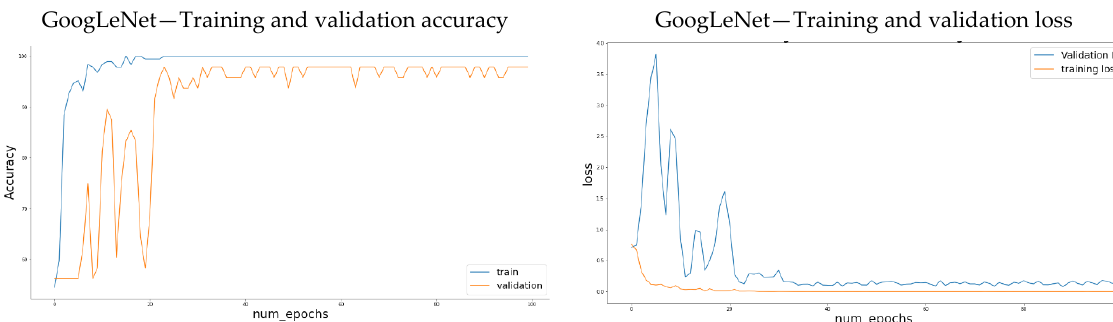
Figure 8. Training and validation accuracy and loss plots obtained from CNN.